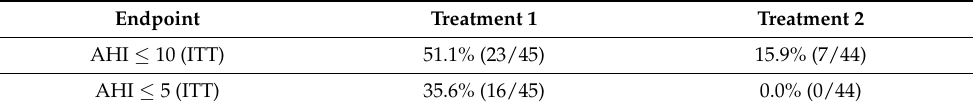
Table 3. Primary Endpoint 1 Sensitivity: Comparison of proportions with AHI ≤ 10 and 5 by randomization group at visit